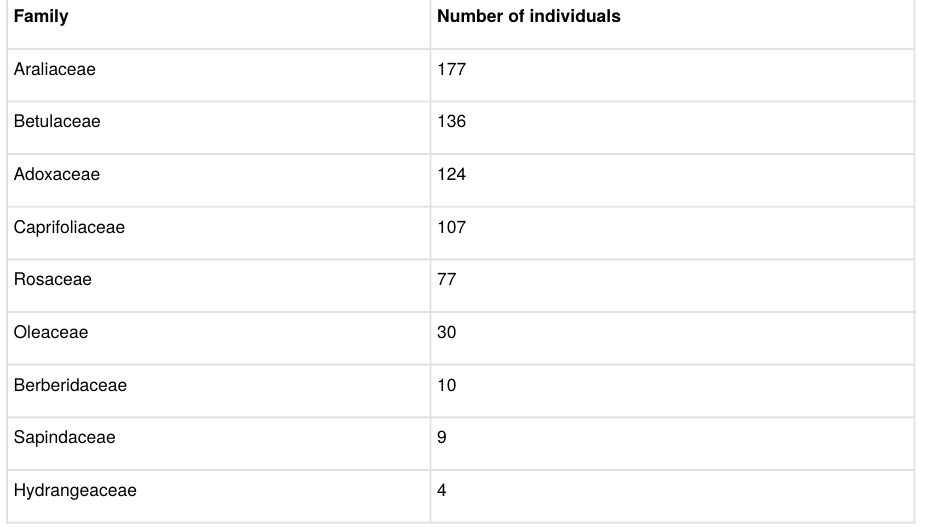
The number of individuals in each family of shrub in Liangshui National Natural